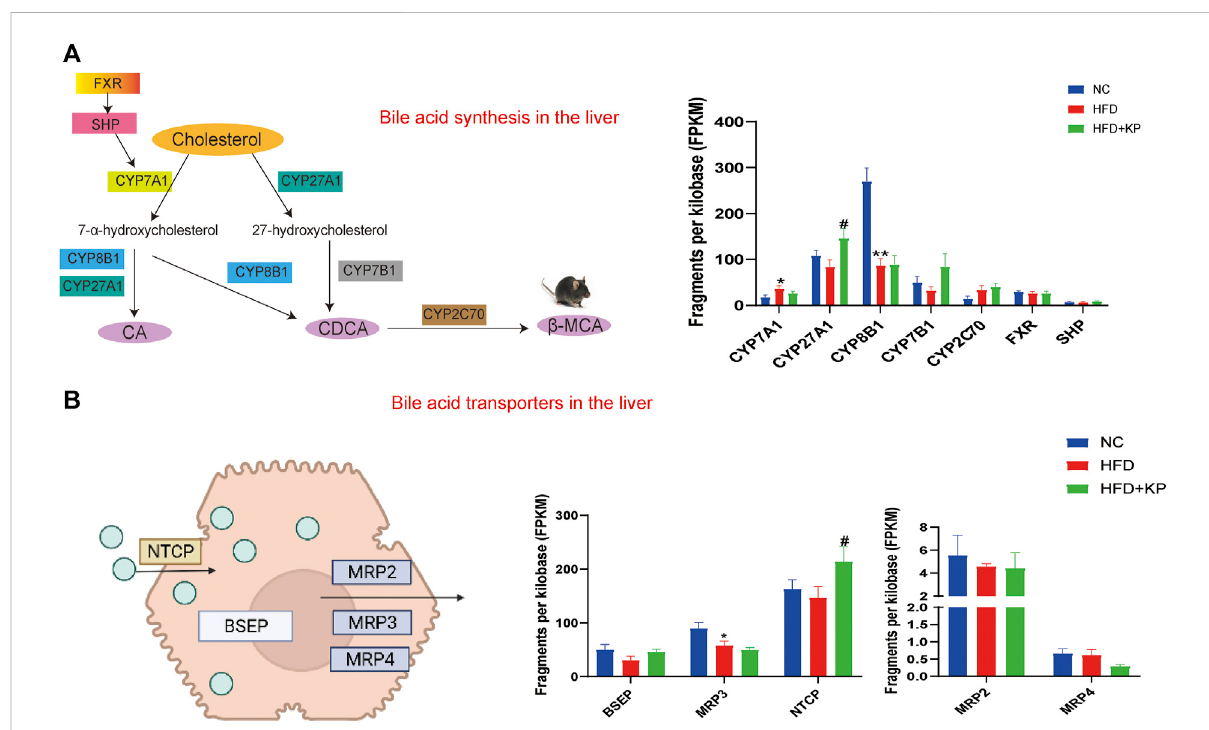
FIGURE 7 KaempferolinducestheexpressionofBAsynthaseandtransportersintheliver. (A) DiagramandmRNAanalysisofbileacidbiosynthesismarkers intheliver(n=5pergroup). (B) DiagramandmRNAanalysisofbileacidtransportersintheliver(n=5pergroup).Allvalueswereexpressedasmean± SEM.* p < 0.05and** p < 0.01,whenNASHmodels(theHFDgroup)werecomparedtocontrolgroups(theNCgroup);# p < 0.05,whenNASHmodels (the HFD group) were compared to NASH models treated with kaempferol (the HFD + KP group). CYP7A1, cholesterol-7 α -hydroxylase; CYP27A1, mitochondrial sterol 27-hydroxylase; CYP8B1, sterol 12 α &hyphen; hydroxylase; CYP7B1, oxysterol 7 α &hyphen ;hydroxylase; CYP2C70, cytochromeP450family2subfamilycpolypeptide70;FXR,farnesoidXreceptor;SHP,smallheterodimerpartner;BSEP,bilesaltexportpump;MRP2, multidrug resistance-related protein 2; MRP3, multidrug resistance-related protein 3, MRP4, multidrug resistance-related protein 4; NTCP, Na + -taurocholate cotransporting